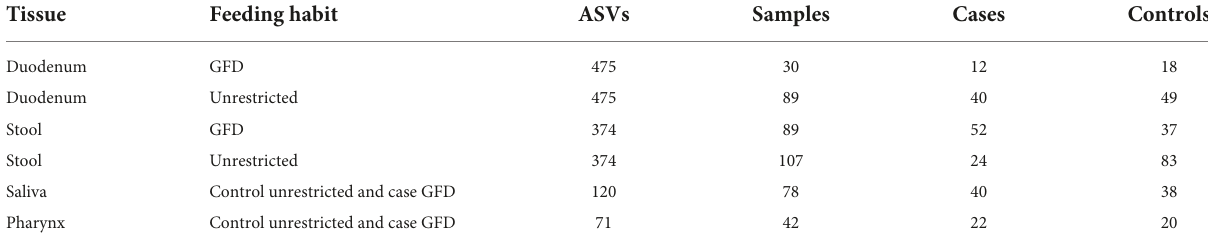
TABLE 2 Statistics of input data to analyze (after filtering samples and ASVs).